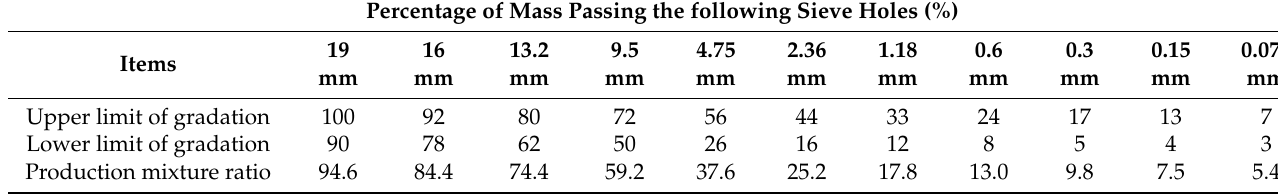
Table 5. AC-20 asphalt mixture grading design.